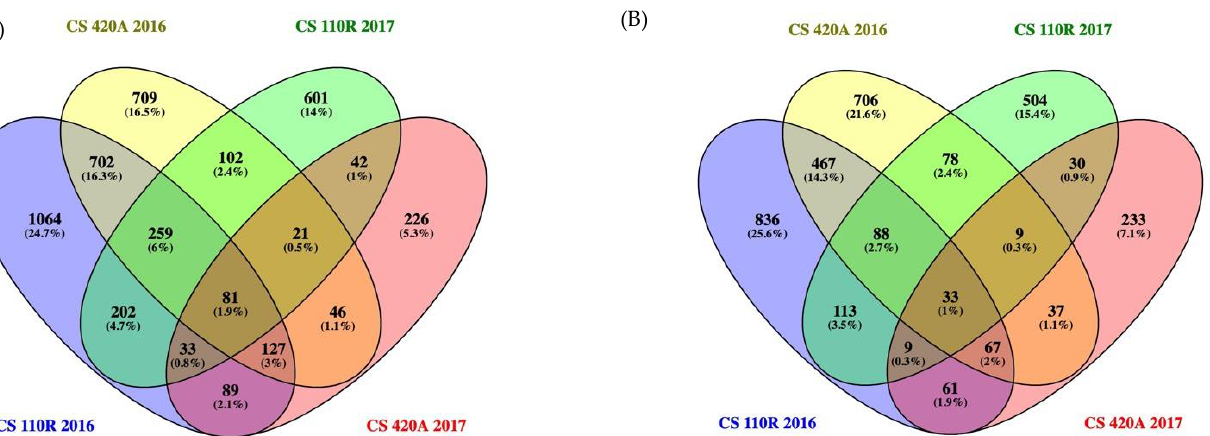
Figure 3. Number of significantly ( p < 0.01) differentially expressed genes at each ripeness level across genotype and season. Different coloring indicates different gene ontology classifications based on biological processes. Negative values indicate significantly down regulated genes and positive values indicate significantly upregulated genes. CS = Cabernet Sauvignon, PV = pre-veraison, V = veraison, PoV = post-veraison, H = harvest.